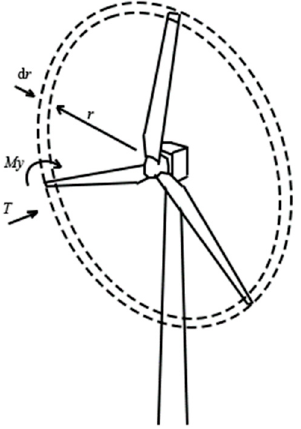
Figure 9. Diagram of loads of the wind wheel.